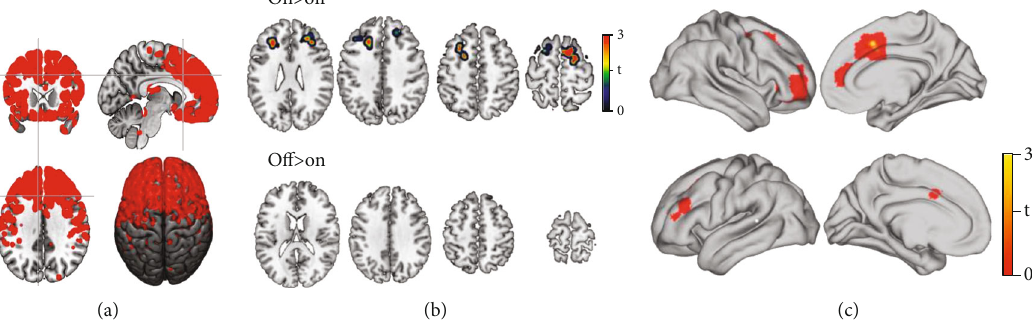
Figure 2: Primary and secondary on-target e ff ect of tACS. (a) The normE- fi eld used as mask for the second-level analysis is shown. (b) BOLD signal changes under the electrodes (DLPFC) during the stimulation, thus comparing the on blocks to the o ff blocks. No signi fi cant BOLD changes are shown comparing the o ff blocks to the on blocks. (c) A surface brain representation of the resulted nodes is shown. More details on the brain activation peaks are reported in Table 1. Right is the right side of the brain. Table 1: MNI coordinates for the main regions showing the increased BOLD signal in the on > off contrast masked for normE- fi eld. Activation loci